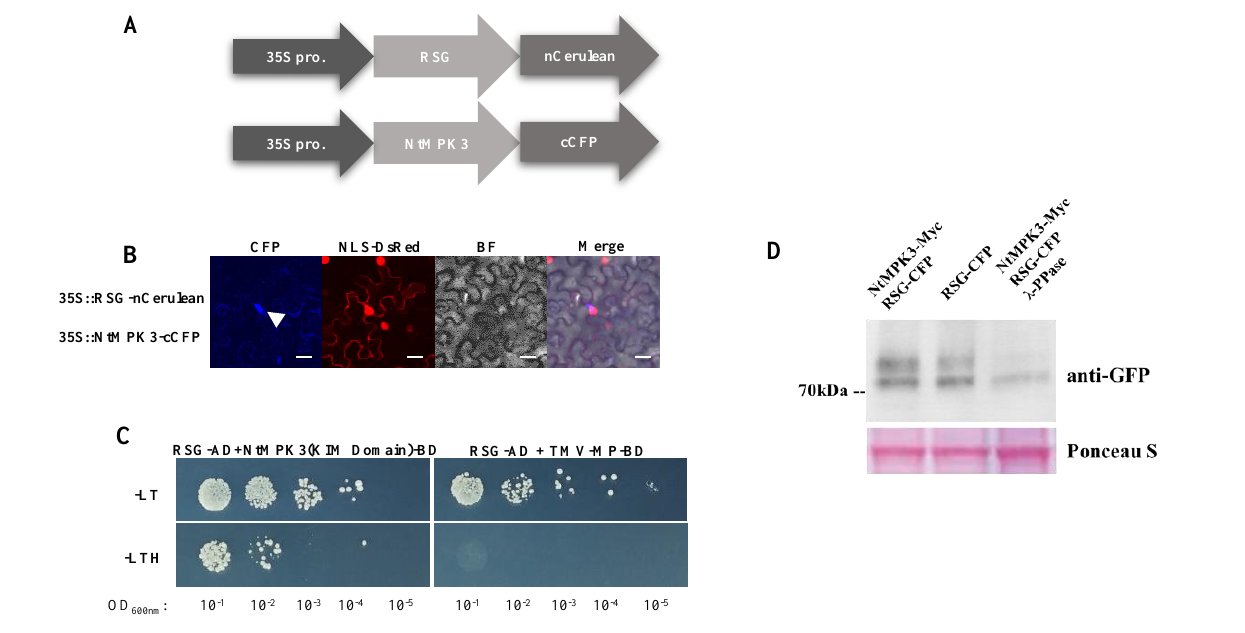
Figure 3. RSG interacts with mitogen-Activated Protein Kinase 3 (MAPK3) in tobacco. (A) Constructs of 35S-driven RSG-nCerulean and 35S-driven NtMPK3-cCFP. (B) BiFC assay. RSG- nCerulean and NtMPK3-cCFP were transiently expressed in agroinfiltrated leaf epidermis of N. benthamiana. NLS-VirD2 fused with DsRed indicated the localization of nuclear. and analyzed by confocal microscopy three days post-infiltration. CFP signal is in cyan. Images are single confocal sections, representative of images obtained in two independent experiments performed for each protein; for each experiment, three infiltrations were performed on three different leaves, with two images recorded per infiltration. Scale bars= 20 µM. (C) Yeast-two-hybrid interaction assay. LexA-NtMPK3(KIM Domain) was coexpressed with Gal4-AD fused to RSG. selective media (- histidine). (D)